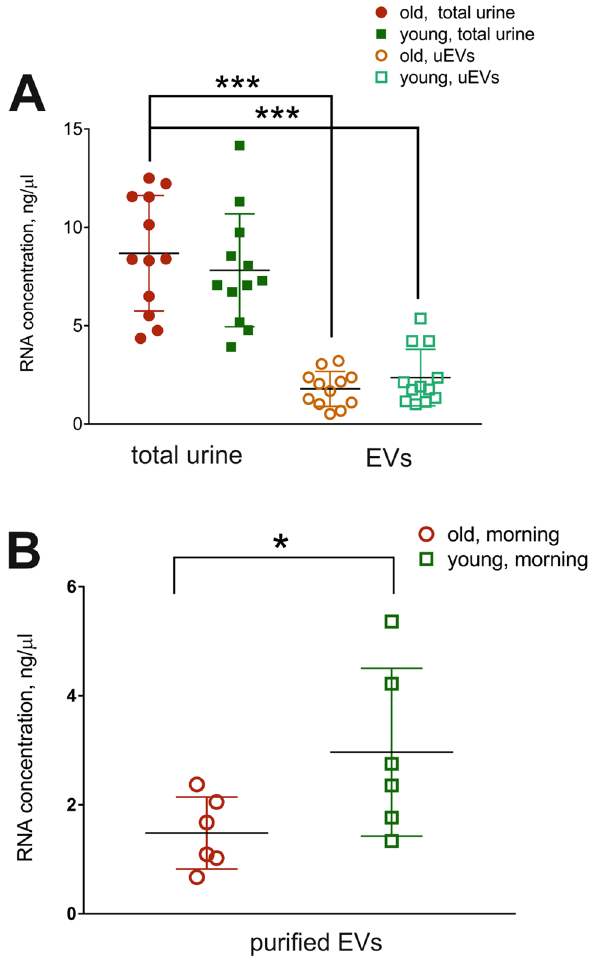
Figure 3. RNA yields from total urine and uEVs in “young” and “old” groups. (A) RNA from 37 ml of cell- free total urine and from uEVs isolated from the same urine volume were eluted in 50 µl of buffer and RNA concentration determined by PCR-based Low Abundance RNA Quantification (LA qPCR) Kit. Significantly lower RNA yields (*** p < 0.001, ANOVA) were observed when using purified uEVs compared to the total urinary RNA, containing both naked and packaged RNAs. (B) Yields of RNA isolated from uEVs present in the morning urine in the “young” group were higher, in agreement with the higher NTA particle counts (*p < 0.05, unpaired, two-tailed